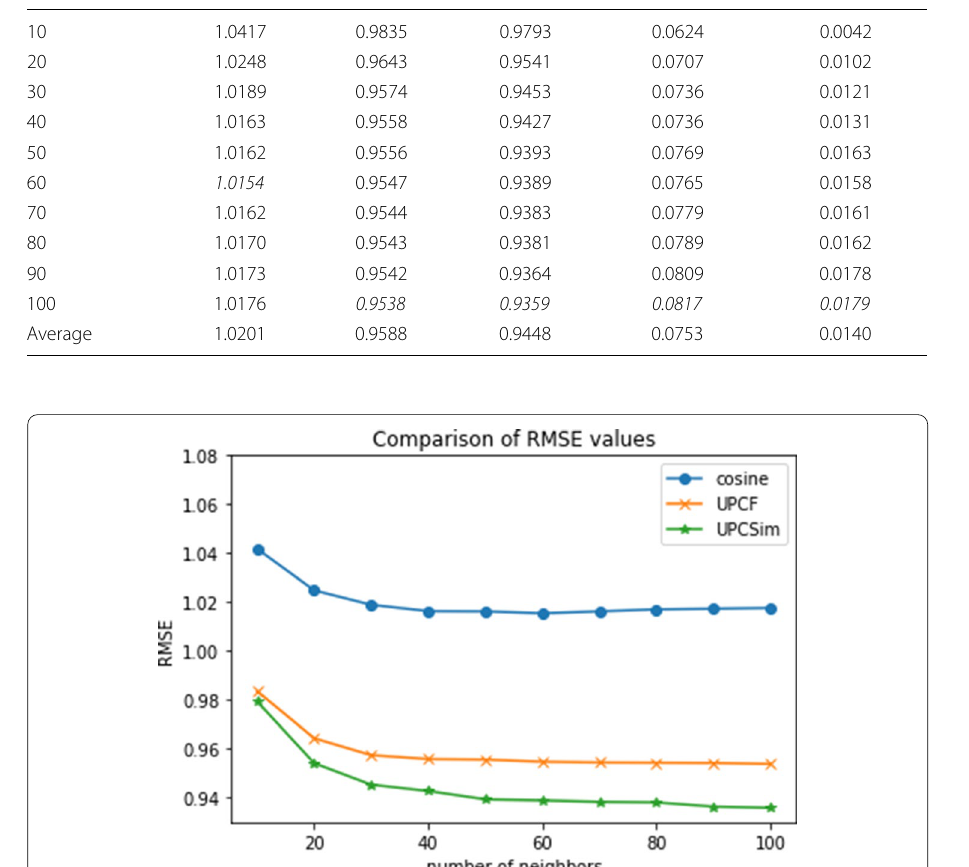
Table 7 Comparison of the average RMSE values of the three algorithms Number of Neighbors